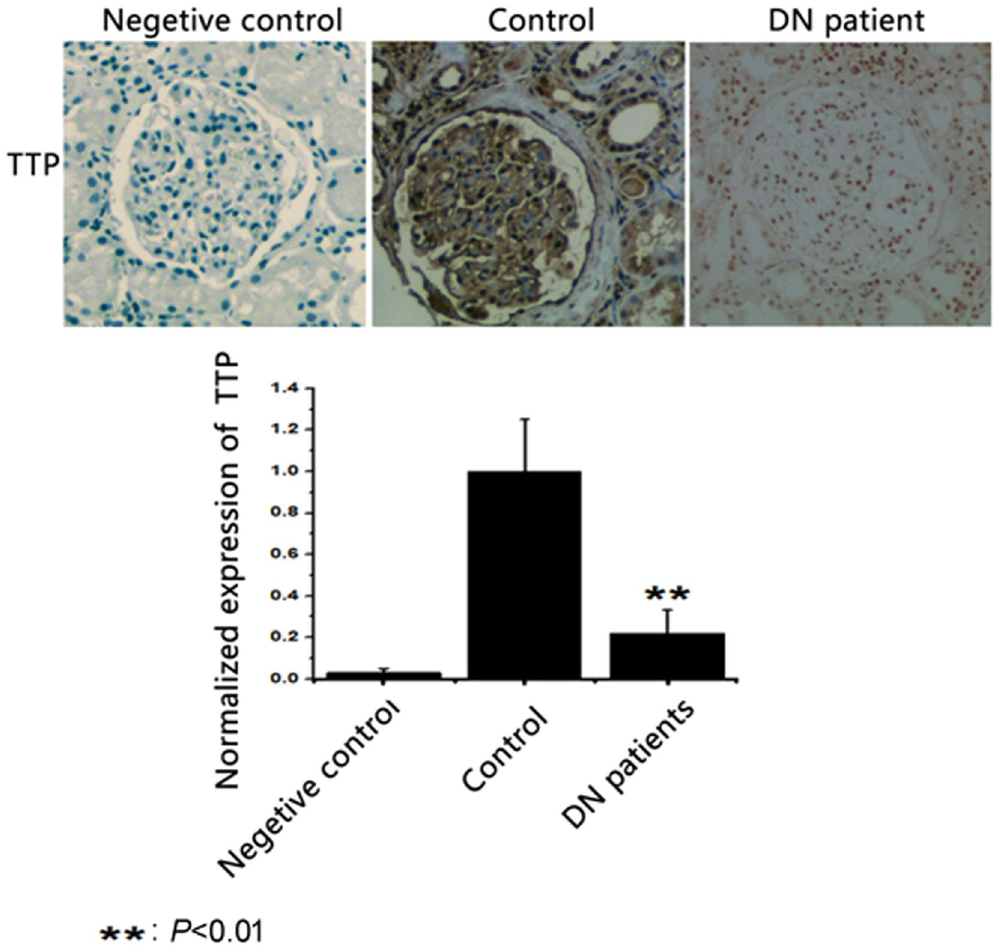
Figure 8. The Expression of TTP in Kidney